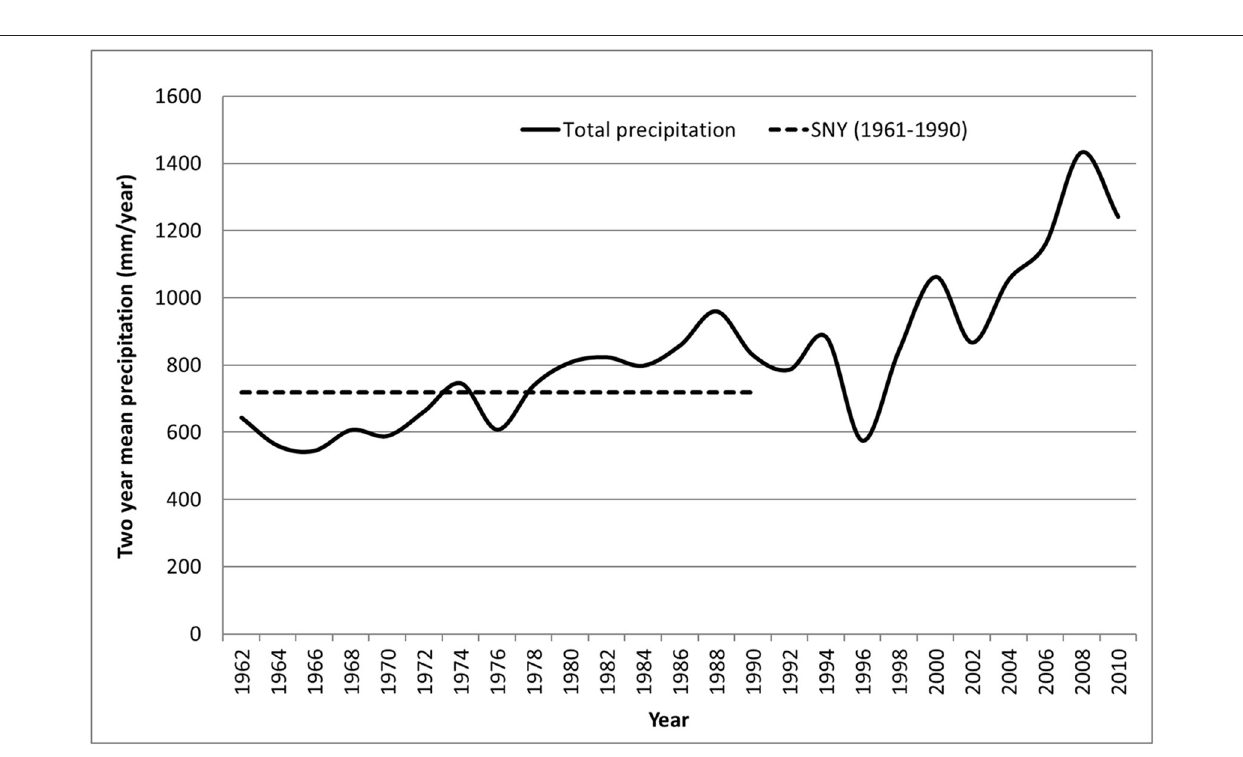
FIGURE 8 | Change in total mean year precipitation in relation to a standard normal year SNY (1961–1990) for Gothenburg area, SW